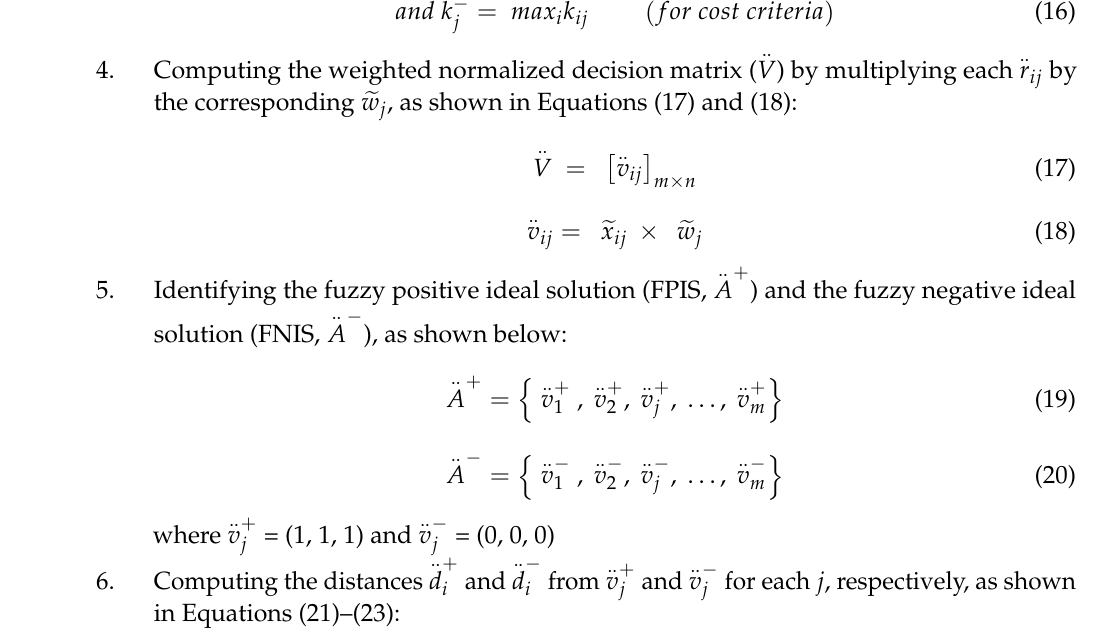
6. Computing the distances